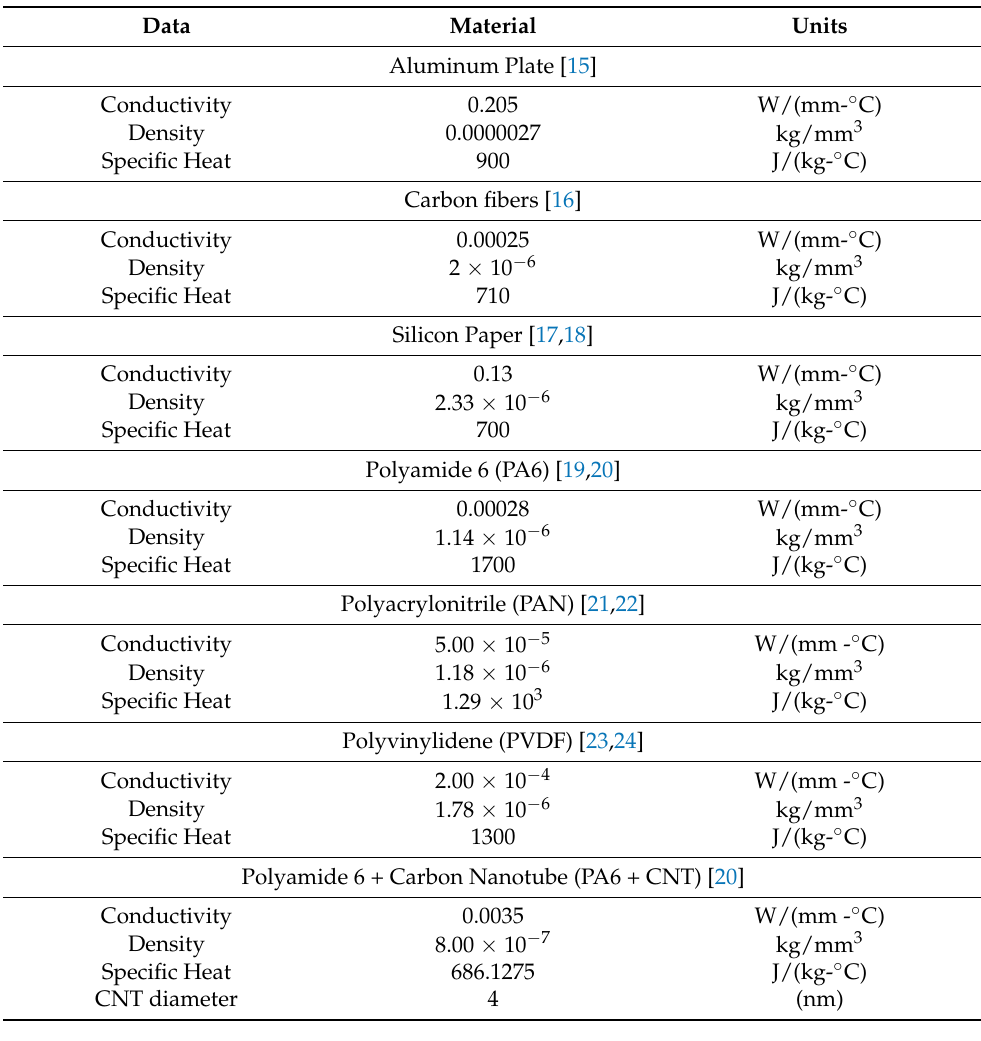
Table 3. Summary of material data used in the simulations.